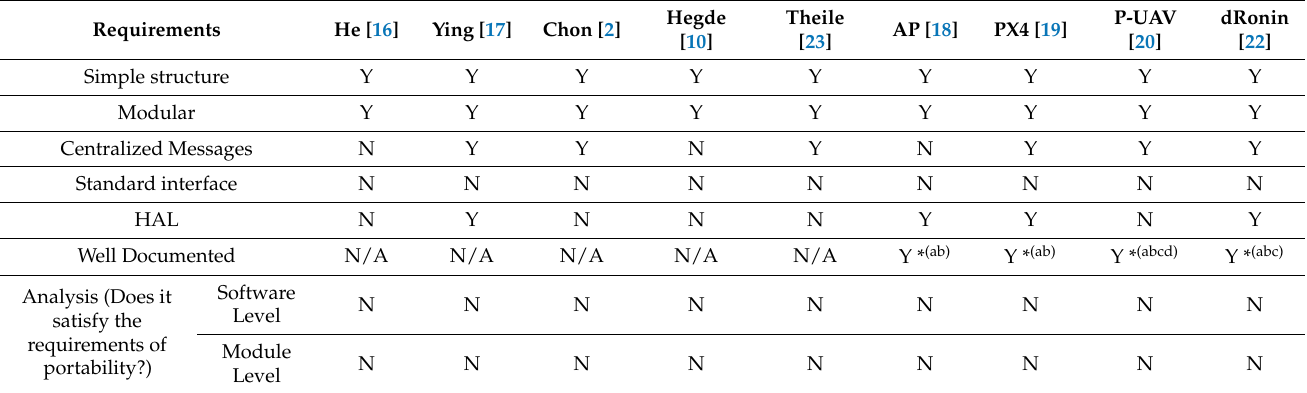
Table 2. Comparison on requirements of the portability of the existing